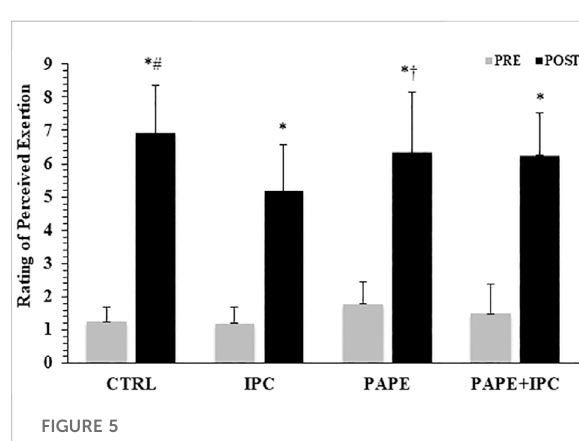
FIGURE 5 Rating of perceived exertion (RPE) before and after the execution of the four sets in the bench press exercise in each experimental condition (CTRL: control, IPC: ischemic pre-